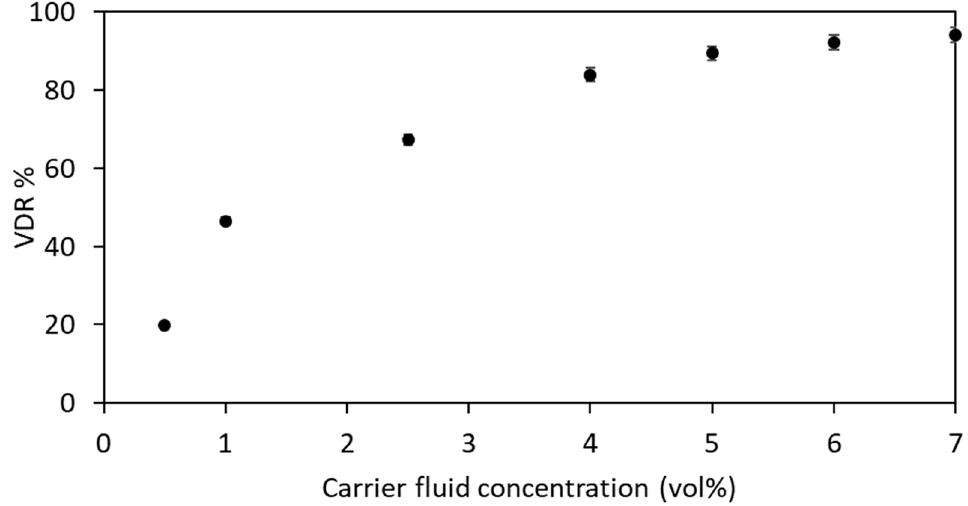
Figure 6. Effect of the nanofluid dosage in the viscosity reduction degree (VRD) of an extra-heavy oil (EHO) at 30 ◦ C at a fixed shear rate of 10 s − 1 . The nanofluid is composed of a carrier fluid with a xylene/dimethylformamide ratio of 0.2 and S9 nanoparticles at 1000 mg · L − 1 regarding the EHO.